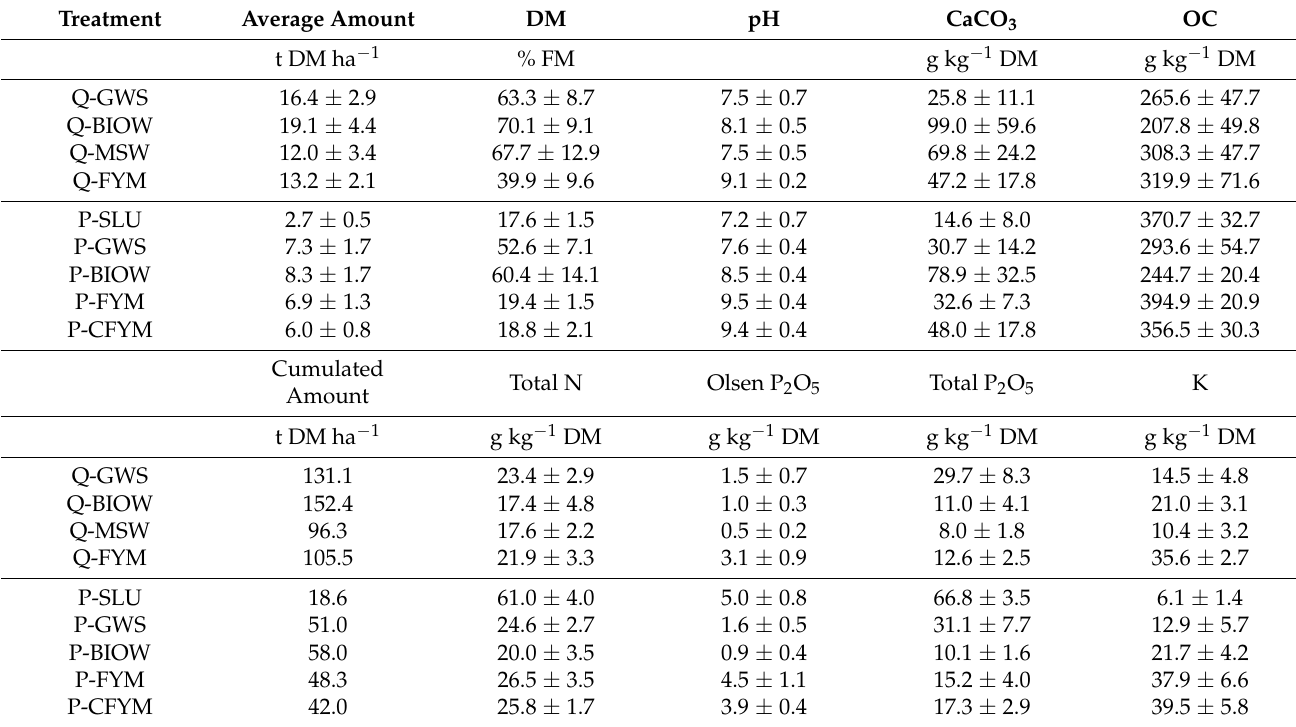
Table 1. Characteristics of the organic waste products, with the following data presented: average values for the period 1998–2013 ± standard deviations ( n = 8 for QualiAgro, n = 7 for PROspective), average and cumulated input amount expressed as ton of dry matter (DM) per hectare, dry matter (DM) expressed as percentage of fresh matter (FM), pH, CaCO 3 and organic carbon (OC) content, content of total and Olsen phosphorus (total/Olsen P 2 O 5 ), total content of nitrogen (N) and potassium (K). See Figures 1 and 2 for treatments signification.